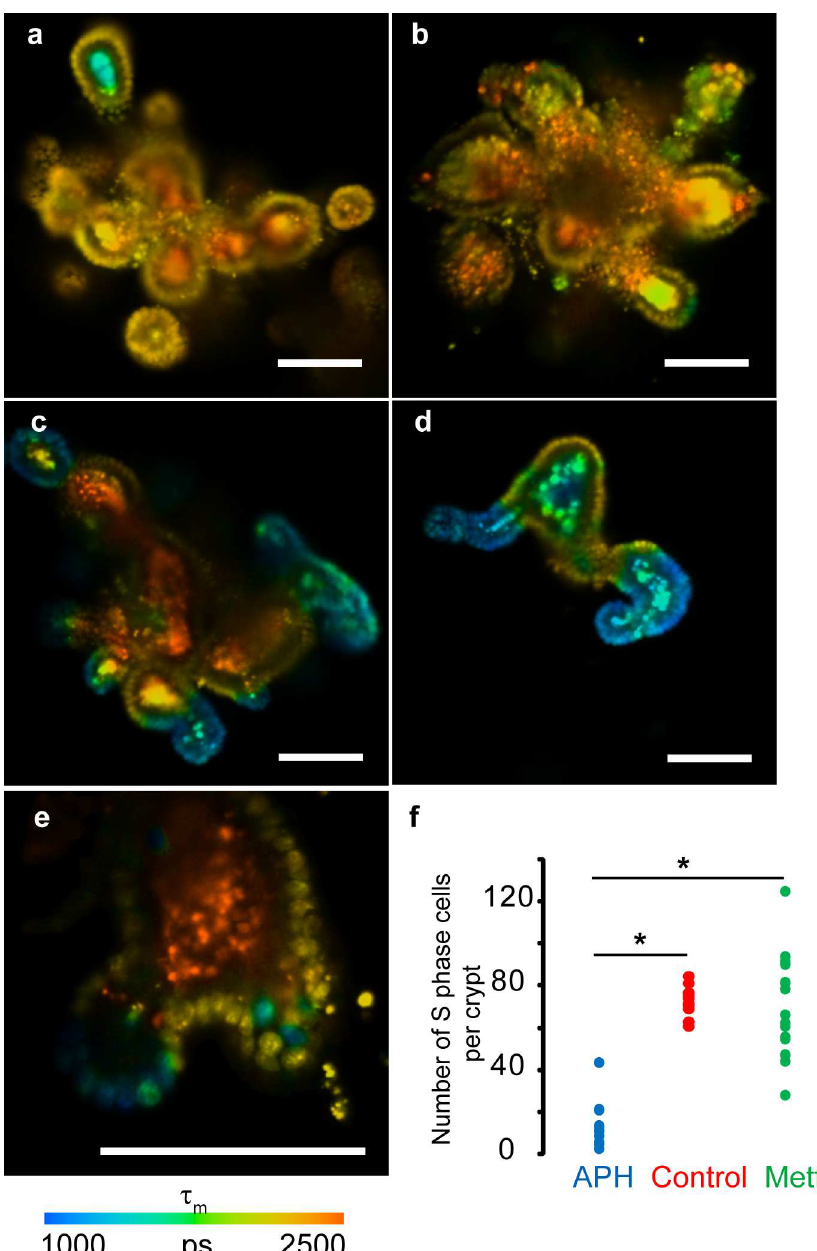
Fig 5. FLIM imaging of live mouse intestinal organoids stained with HXT (1.5 μ M, 4 h) and BrdU. (a) Controlorganoid(no drugs, no BrdU) shows homogenous τ m distributionin epithelialmonolayerand heterogeneous τ m in lumen regions.( b ) Organoidtreated with APH and BrdU (100 μ M, 18 h). (c,d) Heterogeneity of organoids(metformin group). ( e ) FLIM image of an individualcrypt from organoidincubated with BrdU (100 μ M, 4 h) shows fewer nuclei with decreased τ m . ( f ) Effects of APH and metformin compared to non-treatedculture. (N = 9 (APH), N = 12 (control), N = 16 (metformin). N corresponds to a numberof organoidsin each group. Asterisks indicatesignificantdifference betweengroups(p < 0.05). Scale bar is 100 μ m.